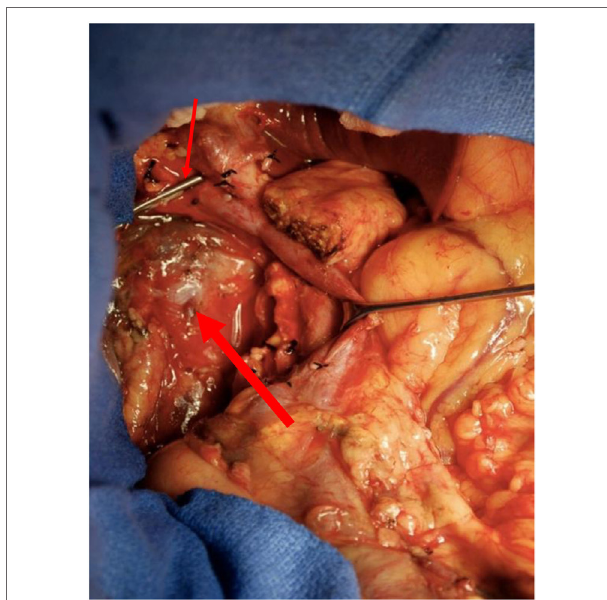
FIgURe 3 | Surgical field at the time of pylorus-preserving pancreaticoduodenectomy in region of the uncinate margin at the superior mesenteric vein (thin arrow), superior mesenteric artery, and inferior vena cava were intraoperative low-kV radiation therapy was administered in retroperitoneal space (thick